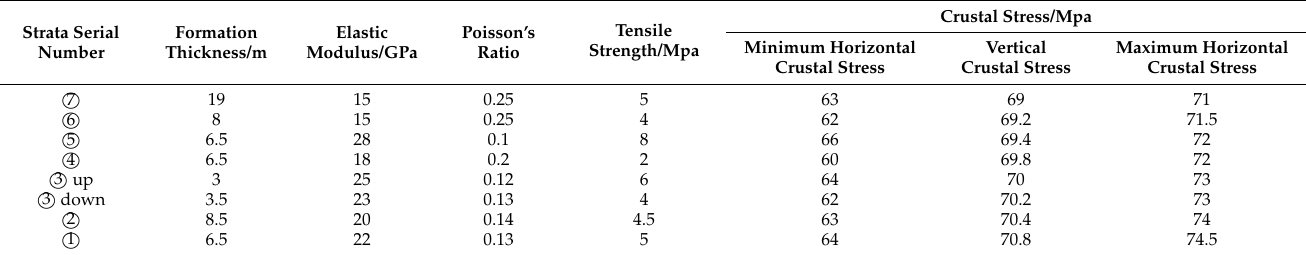
Table 6. The main rock mechanics parameters of the example well.